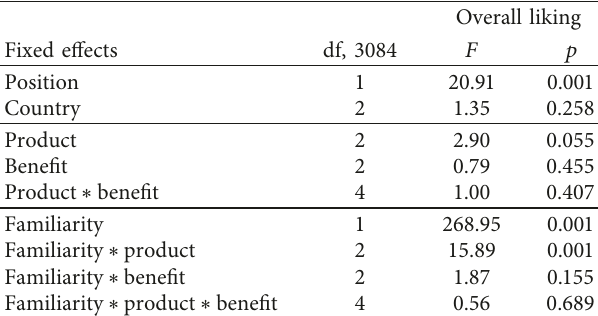
Figure 3: Novelty,interest,overallliking,andexpectedflavorlikingmeasuredona9-pointscaleasafunctionofproductandbenefit.Scales:(a)novelty (“notatallnovel”(1)to“verynovel”(9)),(b)interest(“notatallinteresting”(1)to“veryinteresting”(9)),(c)overallliking(“dislikeextremely”(1)to“like extremely” (9)) and (d) expected flavor liking (“very bad” (1) to “very good” (9)). Values depicted are marginal means derived from Table 4: Overall liking as a function of the experimental factors product and benefits controlled for country and position (pre- sentation order), extended by familiarity and its interactions (M2).